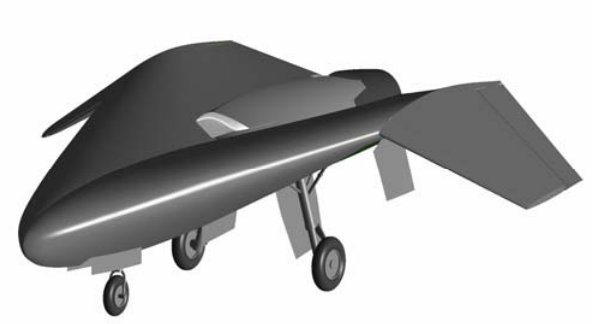
Fig 30. Internal payload containers are closed, all undercarriage legs deflected down. Double covers of each undercarriage containers are visible. Aircraft is ready to land. This is a bottom- side view